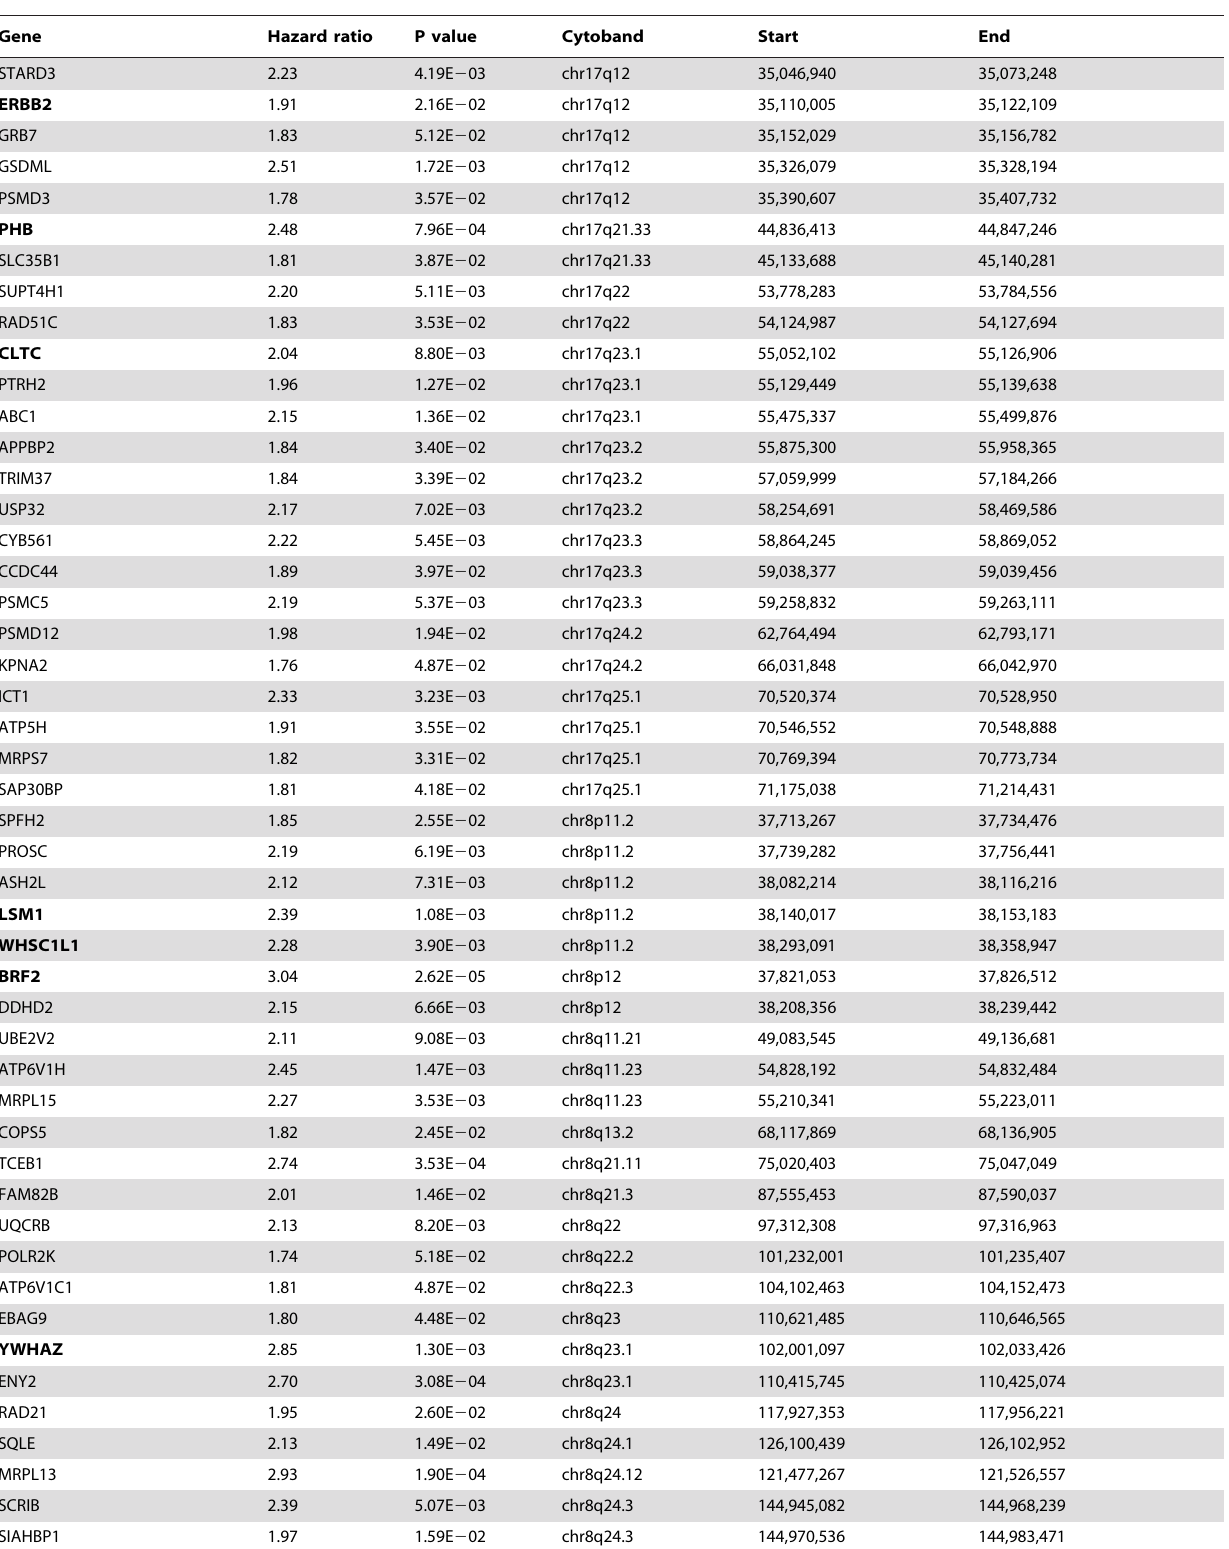
Table 1. Over-expressed genes in chromosomal regions 17q12, 17q21.33-q25.1, 8p11.2 and 8q24.3 associated with early relapse in ER + breast cancers treated with